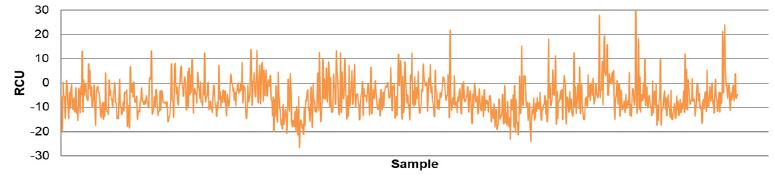
Figure A23. Prediction error of PMM model testing dataset for RCU output variable.